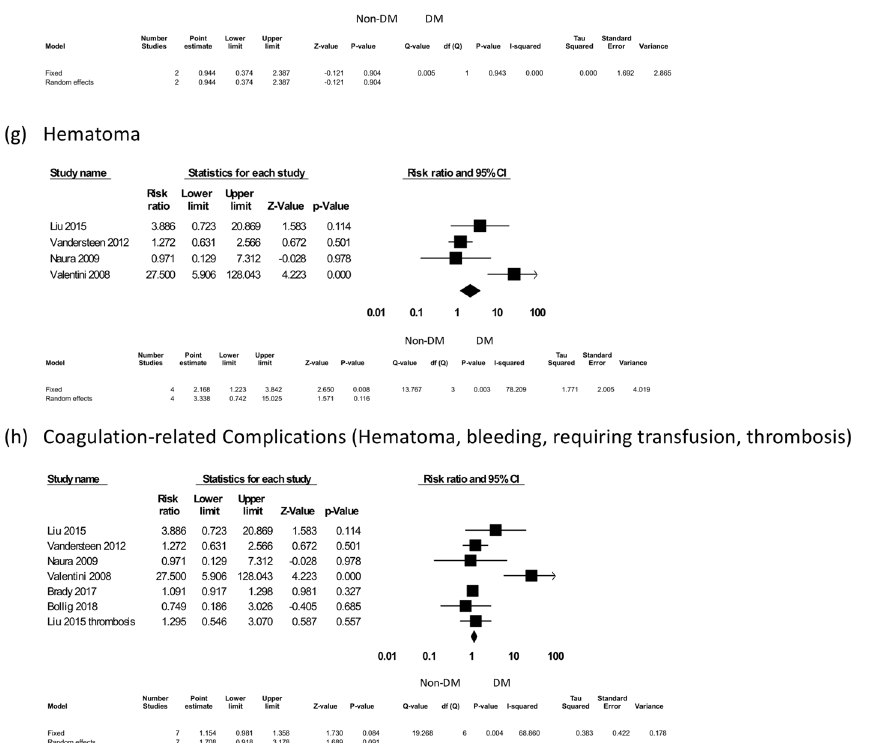
Figure 5. The individual surgical complications forest plot, part II: dehiscence, fistula, plate exposures, hematoma, and coagulation-related complications. *Eskander 32